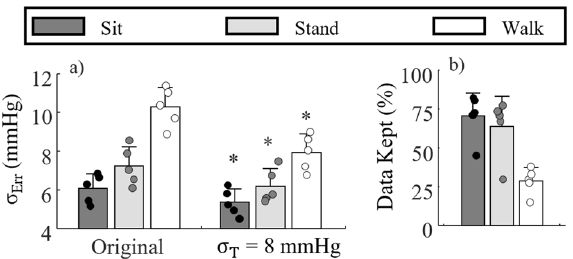
Figure 7. ( a ) Comparison of error standard deviation for the original NARX + ANN Sys + PAT Log model and the same model using a σ T = 8 mmHg during sitting, standing, and walking, and ( b ) percentage of data kept (prediction interval < 8 mmHg). Bars represent the mean of all subjects and the error bars show ± SD. Each data point represents one participant. (*) t-test with p < 0.05 with respect to their original